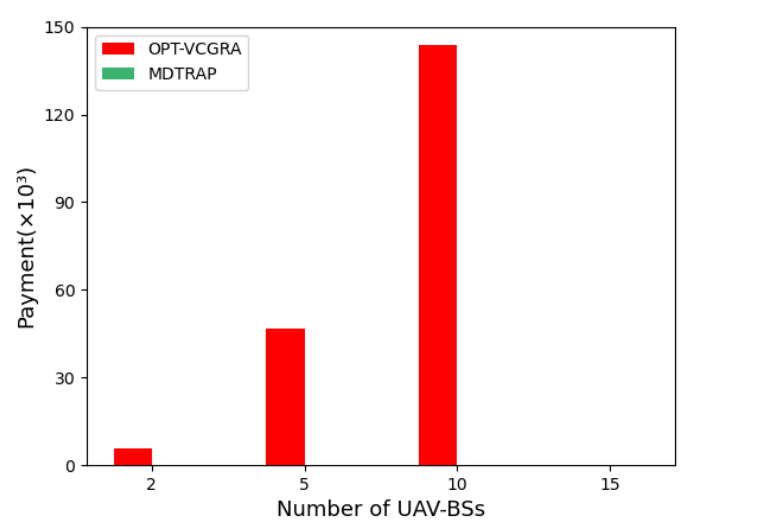
Figure 8. The total amount paid by the VSP to IoT devices under different numbers of